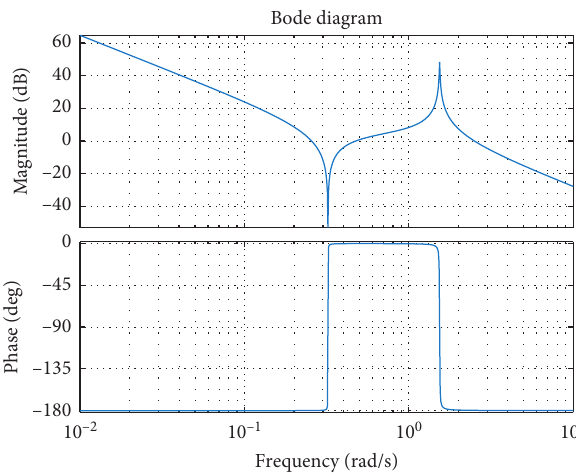
Figure 1: Bode plot of the system